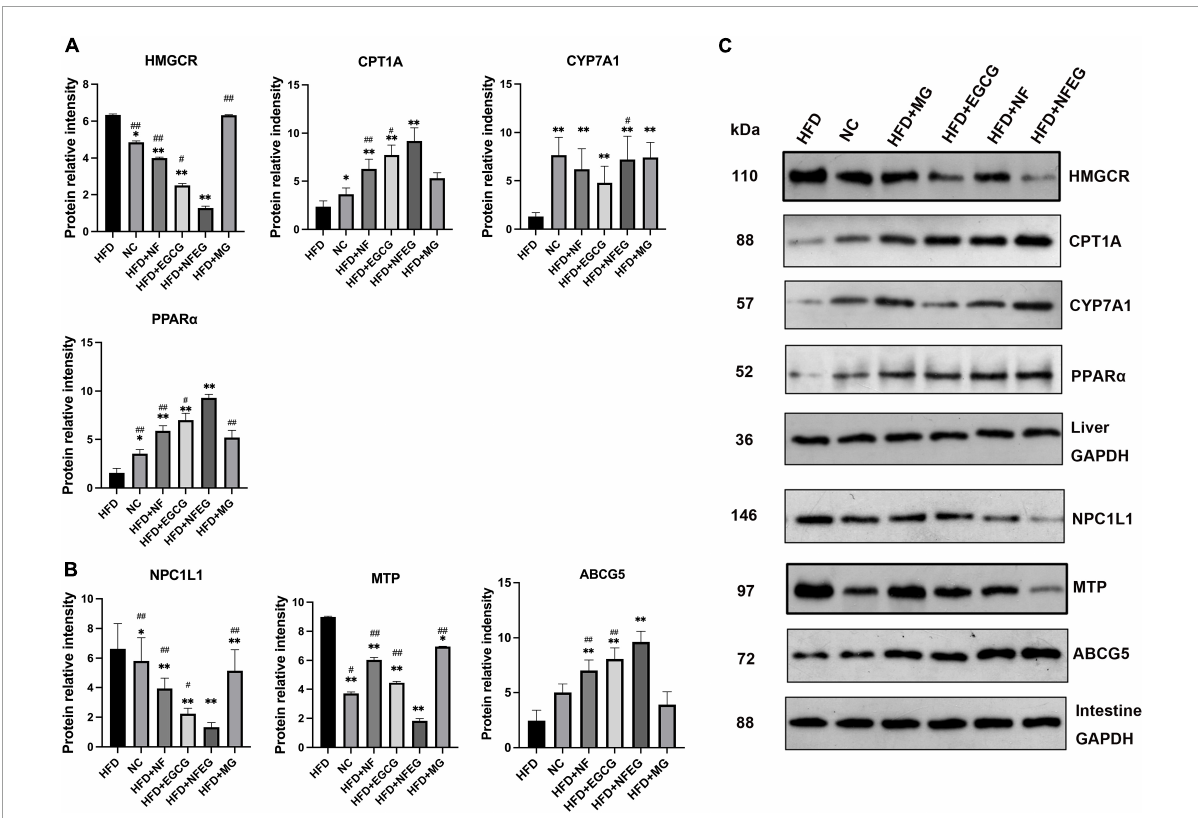
FIGURE4 Protein expression of genes in the liver and small intestine; the results of Western blot were almost consistent with those of qRT-PCR. (A) Protein relative intensity expression of HMGCR, CYP7A1, CPT1A, and PPAR α in rat liver. (B) Protein relative intensity expression of NPC1L1, MTP, and ABCG5 in rat small intestine. (C) WB bands. (* P < 0.05) and (** P < 0.01) vs. HFD group; ( # P < 0.05) and ( ## P < 0.01) vs. HFD + NFEG